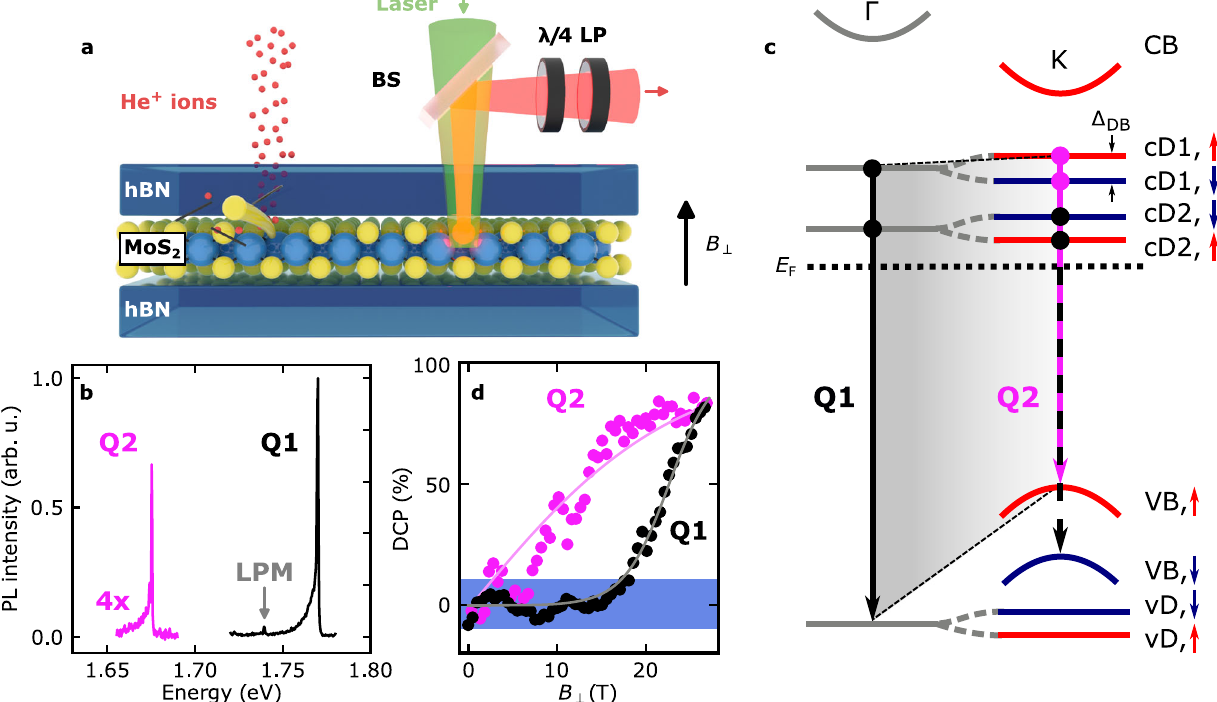
Fig. 1 Defect luminescence of He-ion irradiated monolayer MoS 2 . a Sketch of the monolayer MoS 2 encapsulated in hexagonal boron nitride (hBN) illustrating the He-ion irradiation and the out-of-plane magneto-spectroscopy scheme. b Typical low-temperature photoluminescence (PL) spectra of the quantum emission Q1, Q2, and the local phonon mode (LPM) of Q1. c Illustration of the MoS 2 bandstructure at the K and Γ valleys including the defect states of a sulfur vacancy. The modi fi ed bandstructure shows fl at defect-related levels vD, cD2, and cD1. The red (blue) color represents the spin-up (spin-down) eigenstate of the associated band. A small spin splitting of the defect states is observed in our calculations at the K / K 0 valleys, as discussed in the main text. At B ⊥ = 0 T, the Fermi energy E F lies below the unoccupied defect states. Solid circles mark signi fi cant defect states. d Degree of circular polarization (DCP) versus B ⊥ for Q1 and Q2. The blue shaded area highlights the ±10% experimental uncertainty. The oscillations in the DCP below ~15 T are predominantly due to fringe fi eld induced Faraday rotation in the low temperature objective. The solid lines are fi ts to the data with Eq. (1) for Q1 and a Boltzmann statistics fi t for Q2 (see Supplementary Fig.